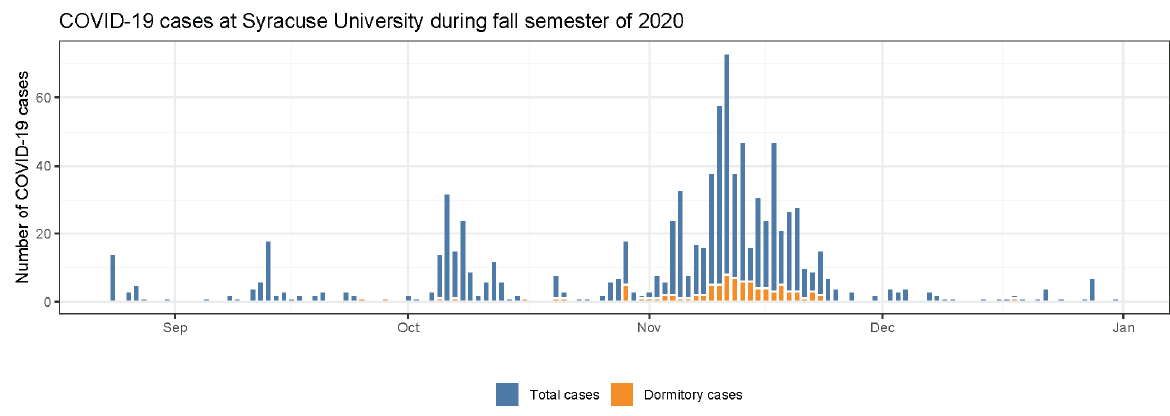
Figure 3. Daily COVID-19 cases during fall semester 2020 at Syracuse University. The first spikes in August represent COVID-19 cases discovered during pre-arrival and arrival testing.